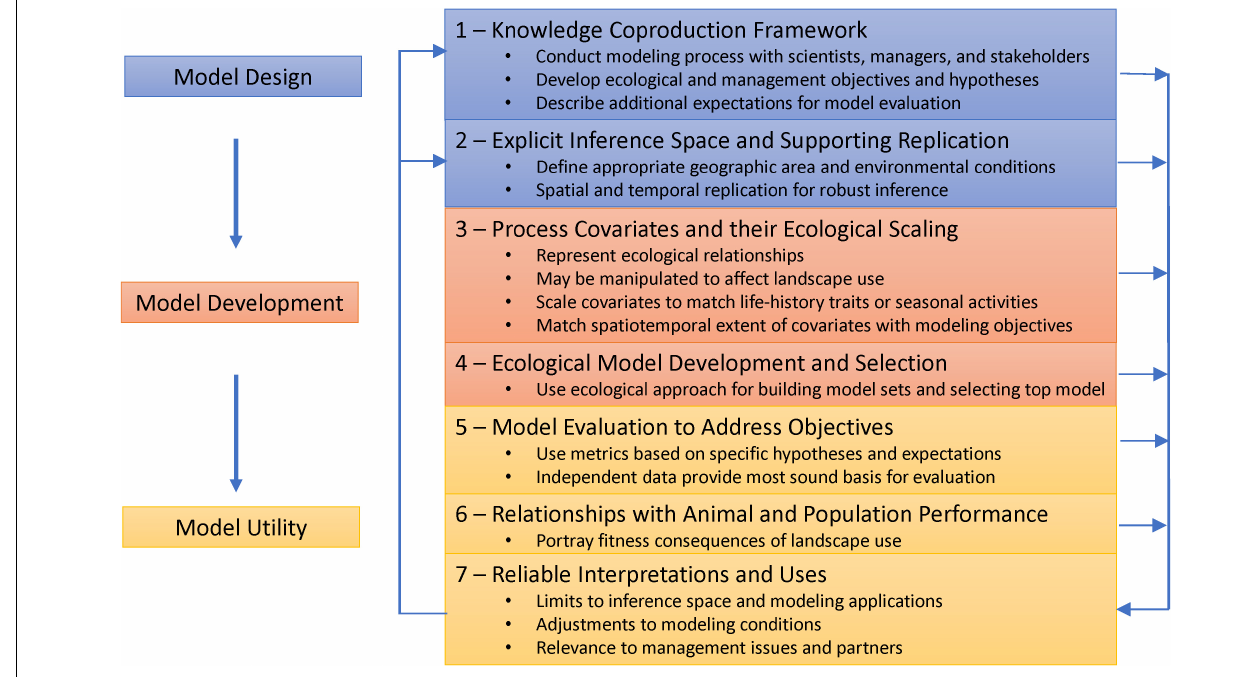
FIGURE 1 | Modeling phases (left boxes) and associated design criteria (right boxes) that outline an ecological and management process (downward arrows) for model design, development, evaluation, and interpretation of landscape use models for ungulates. The primary feedback loop (upward arrows) is generated from interpretation of results from model development, selection, and evaluation, and relationships to performance to determine how well findings support objectives, hypotheses, inference space, and intended uses. Results that do not support model expectations can guide additional studies and modeling to address model deficiencies, using concepts of adaptive management (Walters,